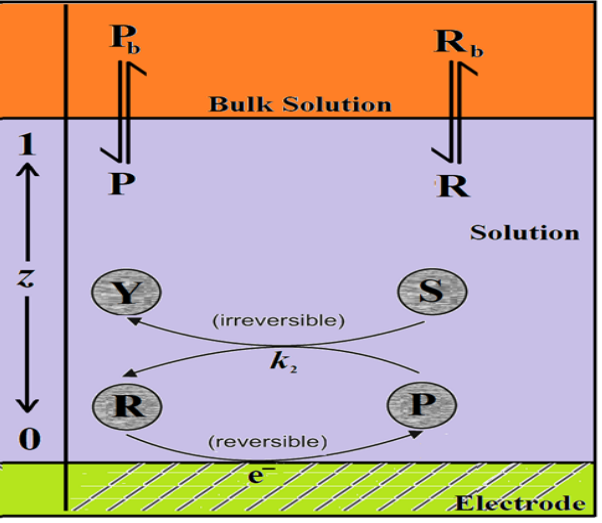
Figure 1. General scheme of a second-order irreversible homogeneous reaction.